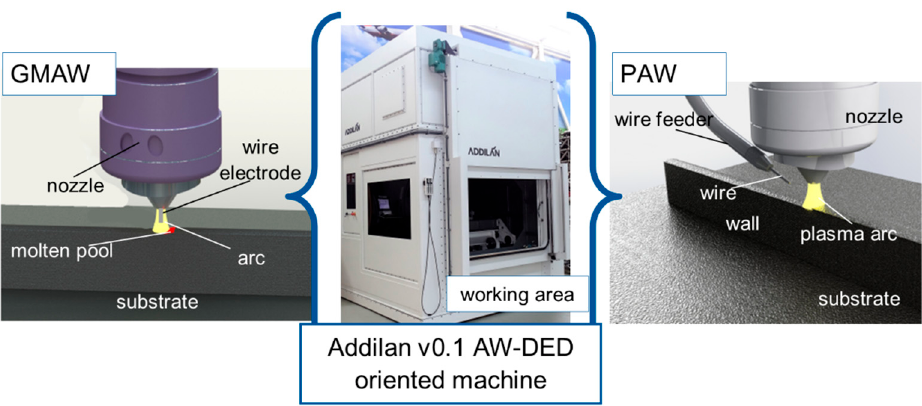
Figure 1. ADDILAN v0.1 machine configurations for additive manufacturing with GMAW and PAW technologies.